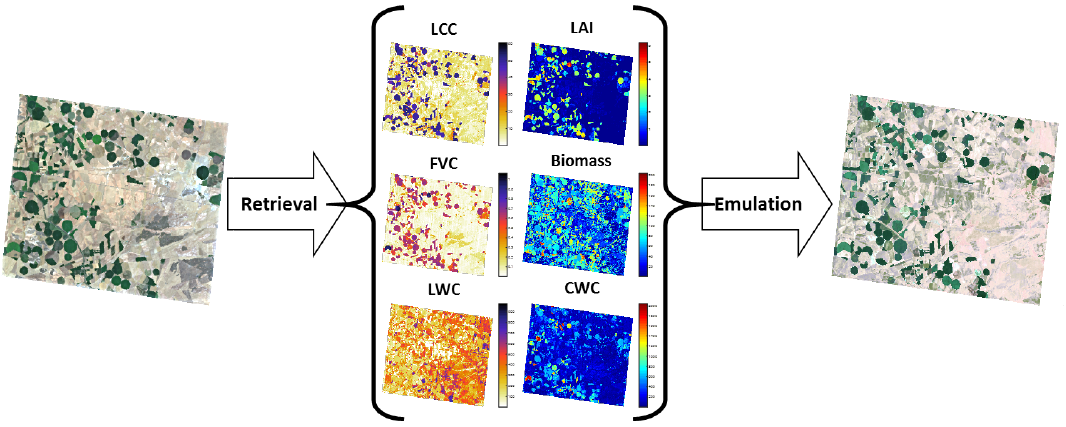
Figure 4. Schematic overview of RGB and emulated synthetic CHRIS image over agricultural site Barrax, Spain (R: 653 nm; G: 553 nm; B: 460